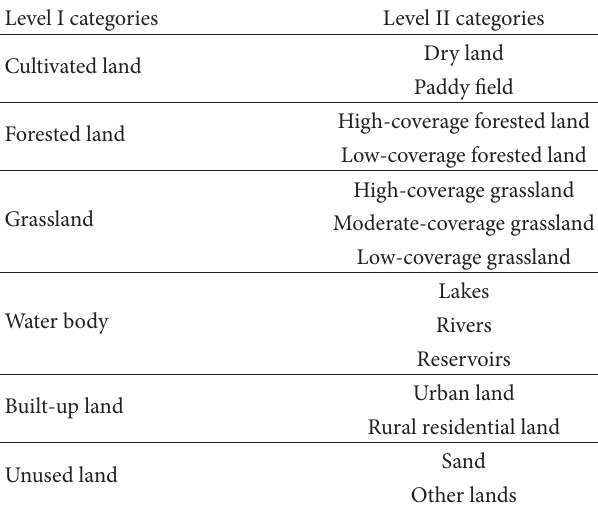
Table 1: Land-use/cover classification in the Dongting Lake